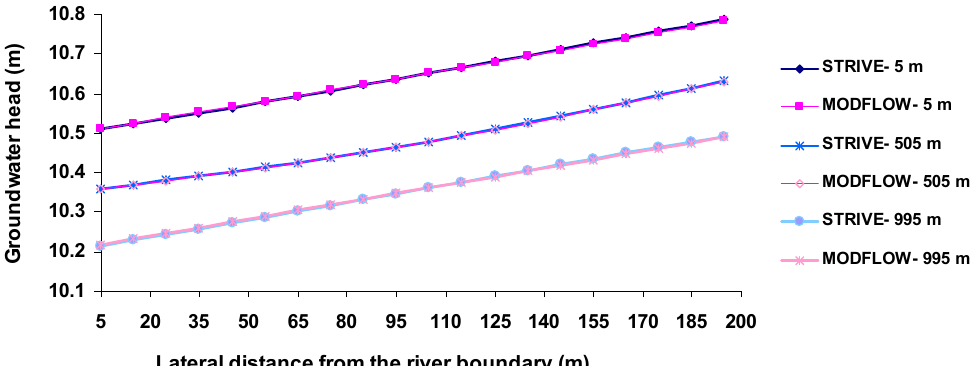
Figure 15. Groundwater head versus lateral distance from the river-aquifer boundary at fixed distances in the longitudinal direction of the river at 5 m (near the upstream model boundary), 505 m (at the middle of the river length), and 995 m (near the downstream model boundary), using STRIVE and MODFLOW, based on interpolated river boundary with a steady-state